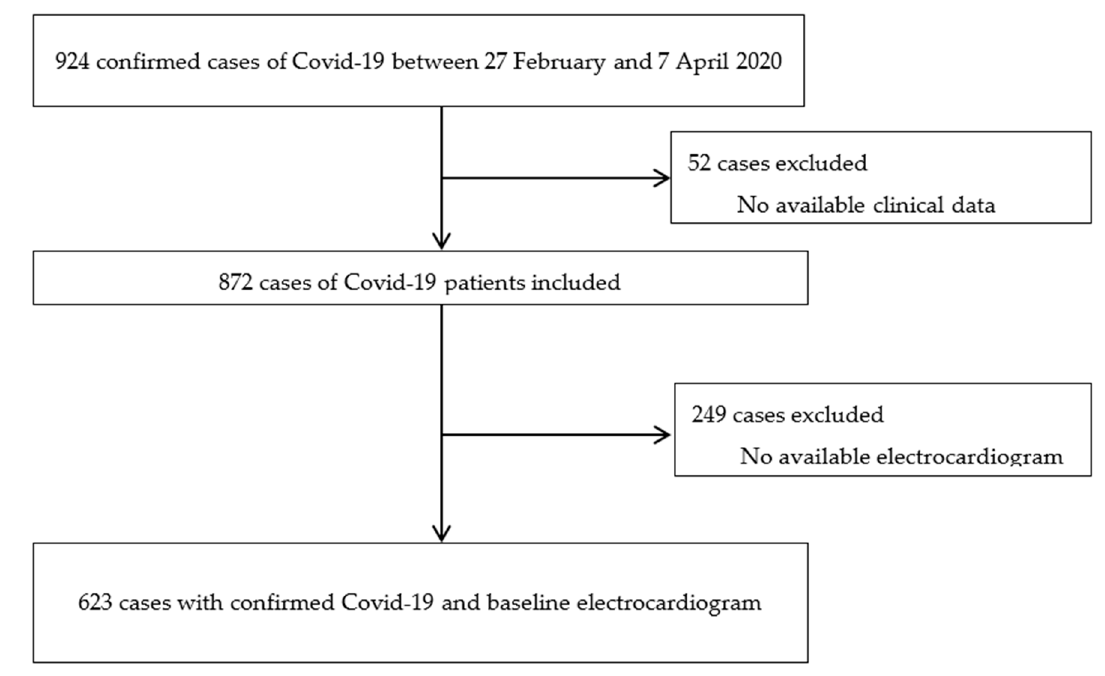
Figure 1. Flowchart of patient selection.